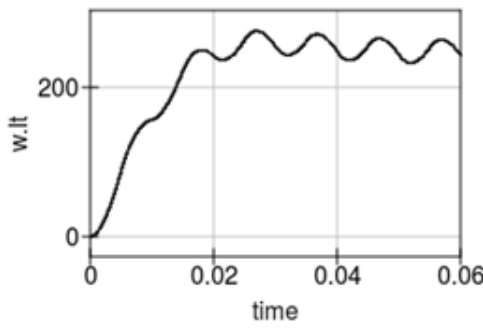
Figure 10. A simulation using Qucs of the rotor speed ω ( t ) under no-load conditions when using a PWM supply voltage with a peak value of 100 V and a duty cycle of 50%.